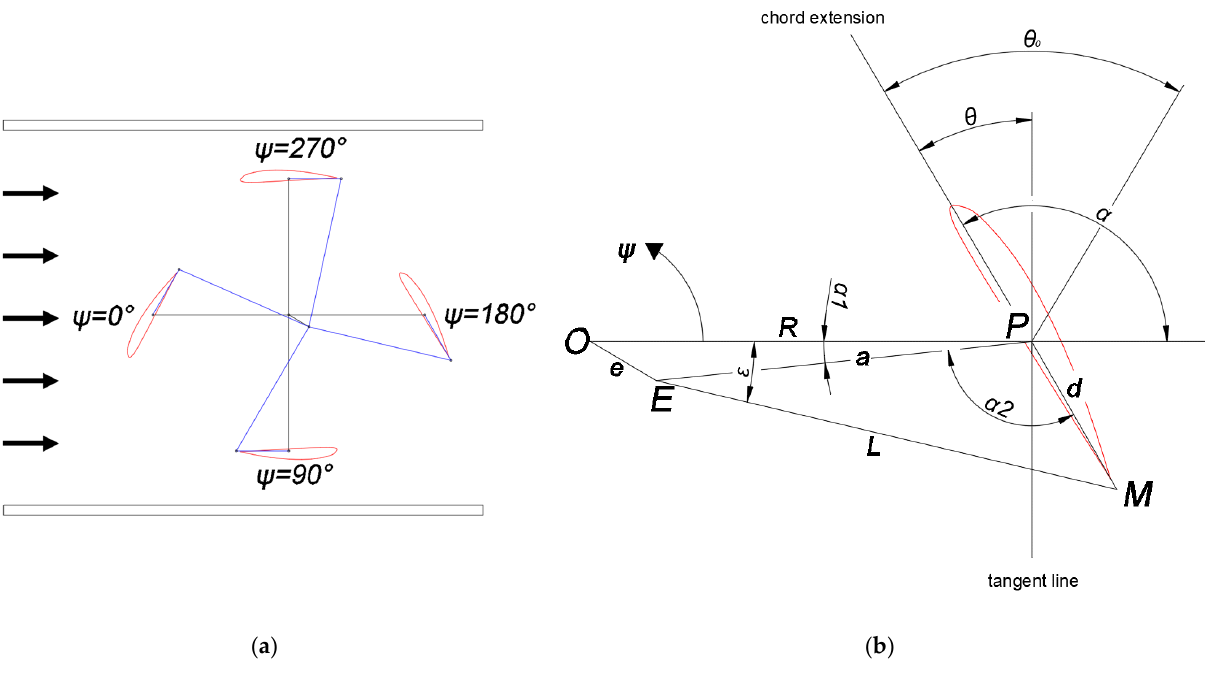
Figure 1. The illustration shows: ( a ) cycloidal rotor with cycloidal control in the channel. ( b ) Frag ‐ ment of the cyclorotor with visible geometrical quantities. of the cyclorotor with visible geometrical